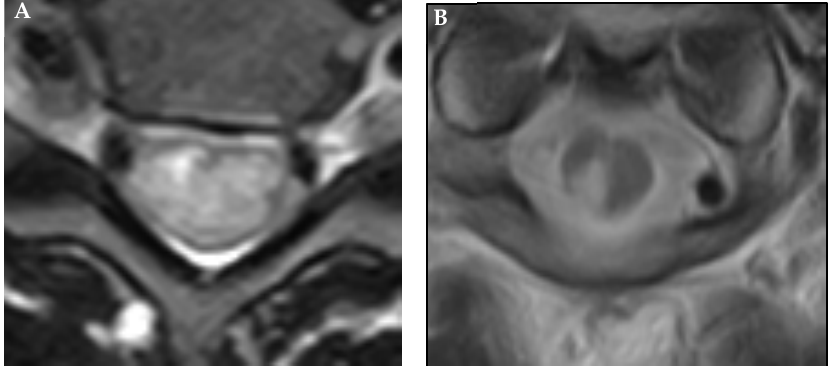
Figure 1. Lesional distribution on axial magnetic resonance imaging (MRI). Extensive ( A ) and focal ( B ) lesions showing a hyperintensity area on T2-weighted images. Spinal cord enlargement was evaluated via sagittal T2-weighted MRI (Figure 2). N.N. evaluated the MRI findings of spinal cord enlargement and lesional area at two different time points. The intraobserver reliability tested with Cohen’s kappa coefficient was 0.93 for the enlargement and 0.85 for the lesional area ( p < 0.01). All case images were evaluated independently by two spine surgeons (K.K. and N.N.) to assess the interobserver error. The interobserver reliability was 0.93 and 0.84 for the enlargement and lesional area, respectively ( p <